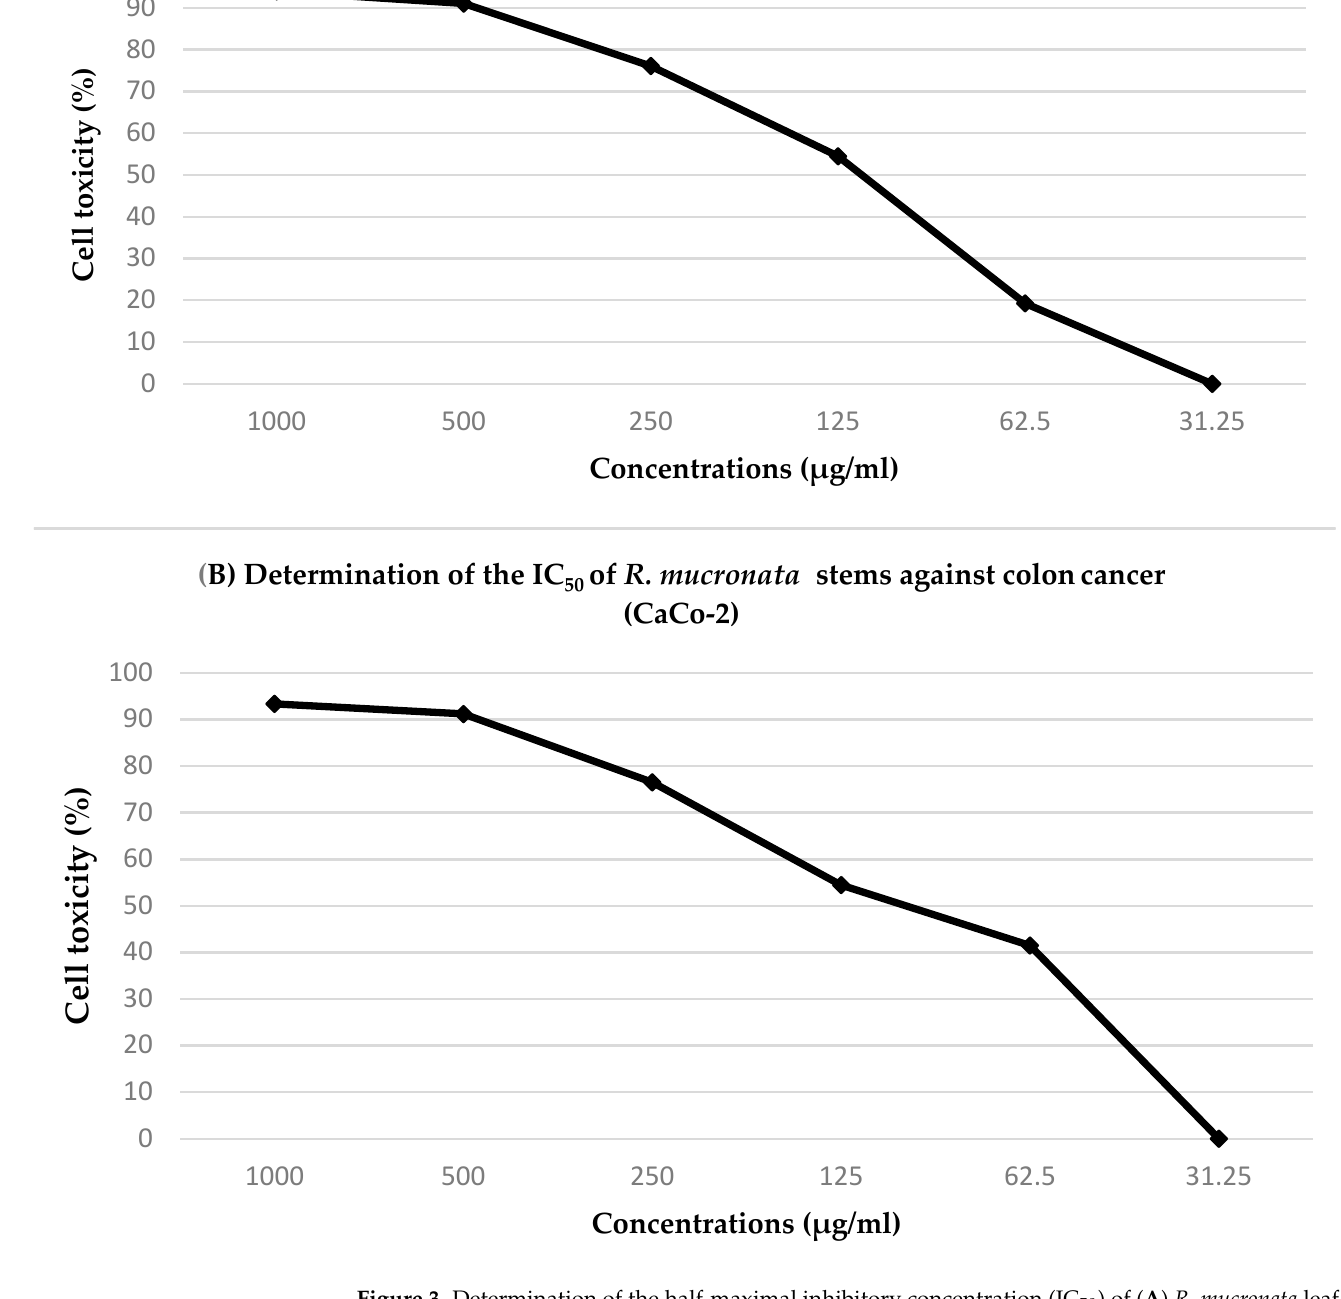
Figure 3. Determination of the half-maximal inhibitory concentration (IC 50 ) of ( A ) R. mucronata leaf extract and ( B ) R. mucronata stem extract against colon cancer (CaCo ‐ 2).